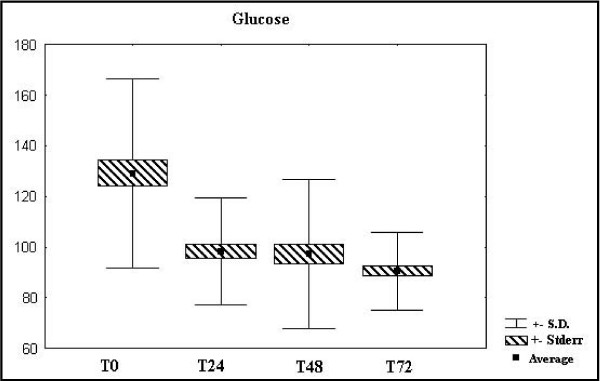
Glucose variation.